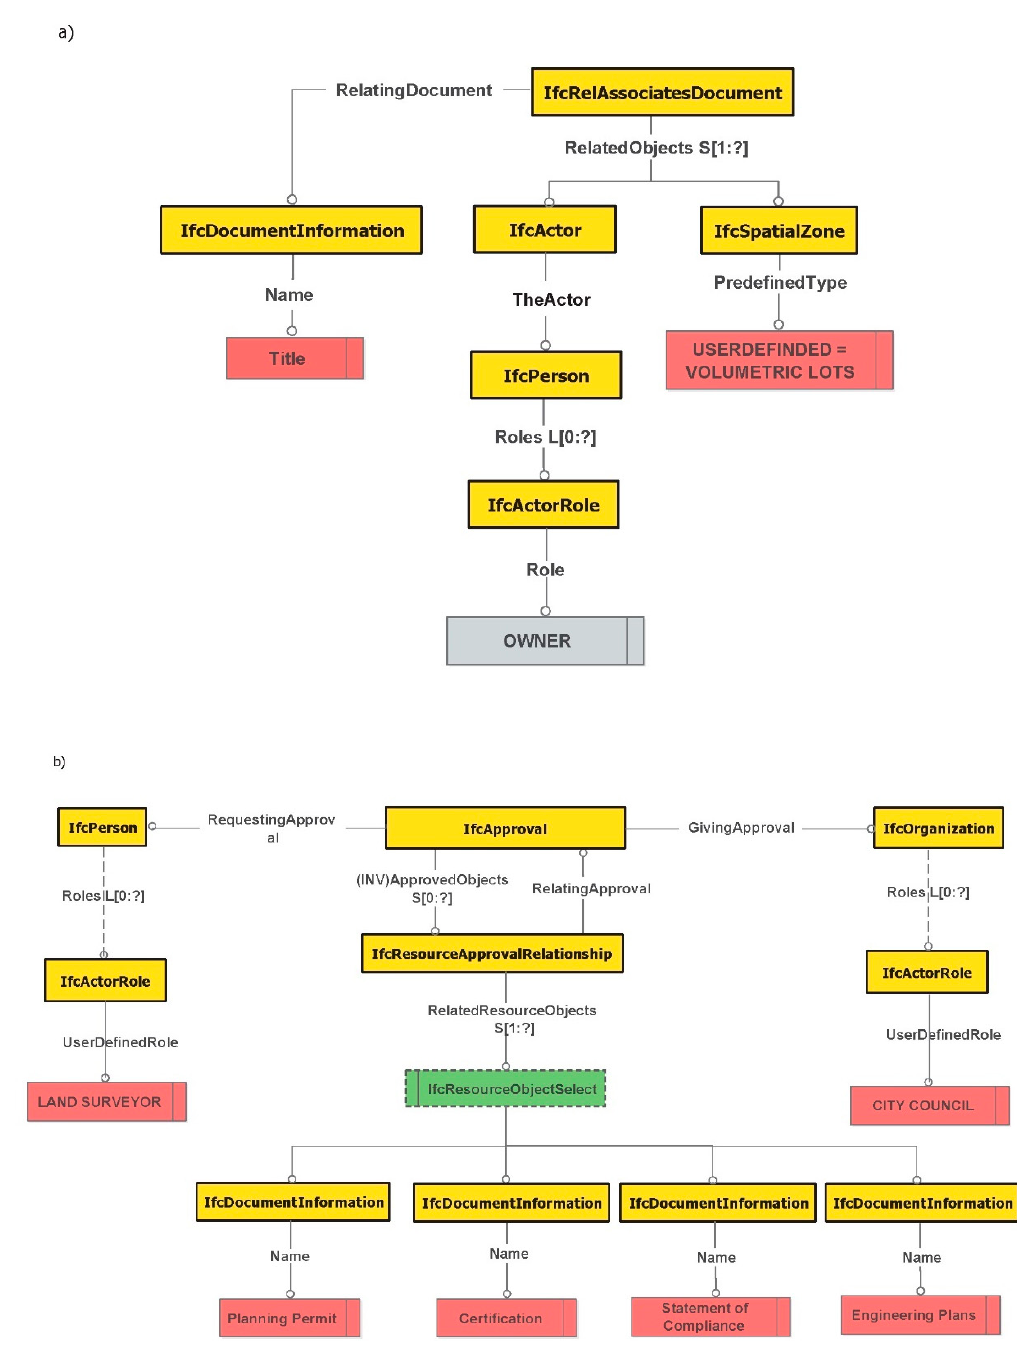
Figure 9. ( a ) Associating the title document to its owner and volumetric lot legal interest ( b ) Modelling legal documents exchanged between council and land surveyor within the IFC schema.